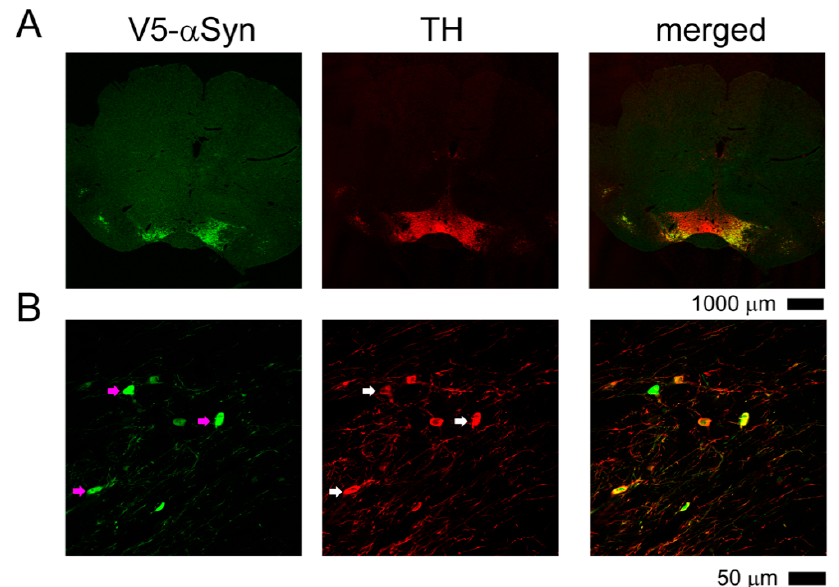
Figure 4. α Syn is expressed in nigral TH neurons of DAT-Cre rats receiving AAV-DIO- α Syn. DAT-Cre rats were stereotaxically injected with AAV-DIO- α Syn to SNcd. Brain tissues were collected for TH and V5- α Syn immunostaining. ( A ) At lower magnification, TH and V5- α Syn were present in the nigra region. ( B ) At higher magnification, almost all V5- α Syn (+) cells co-expressed TH immunoreactivity (arrows) in the SNcd.